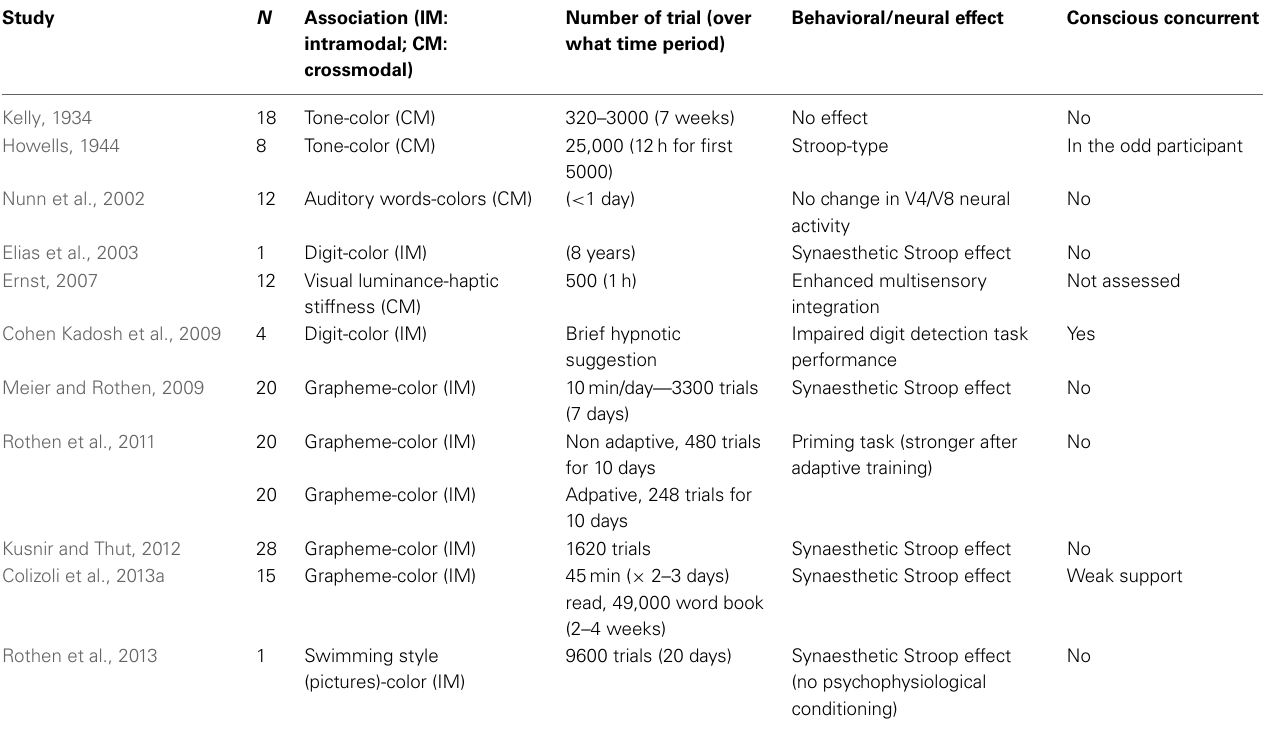
Table 1 | Summary of studies that have tried to induce an association between sensory features or dimensions comparable to synaesthesia.